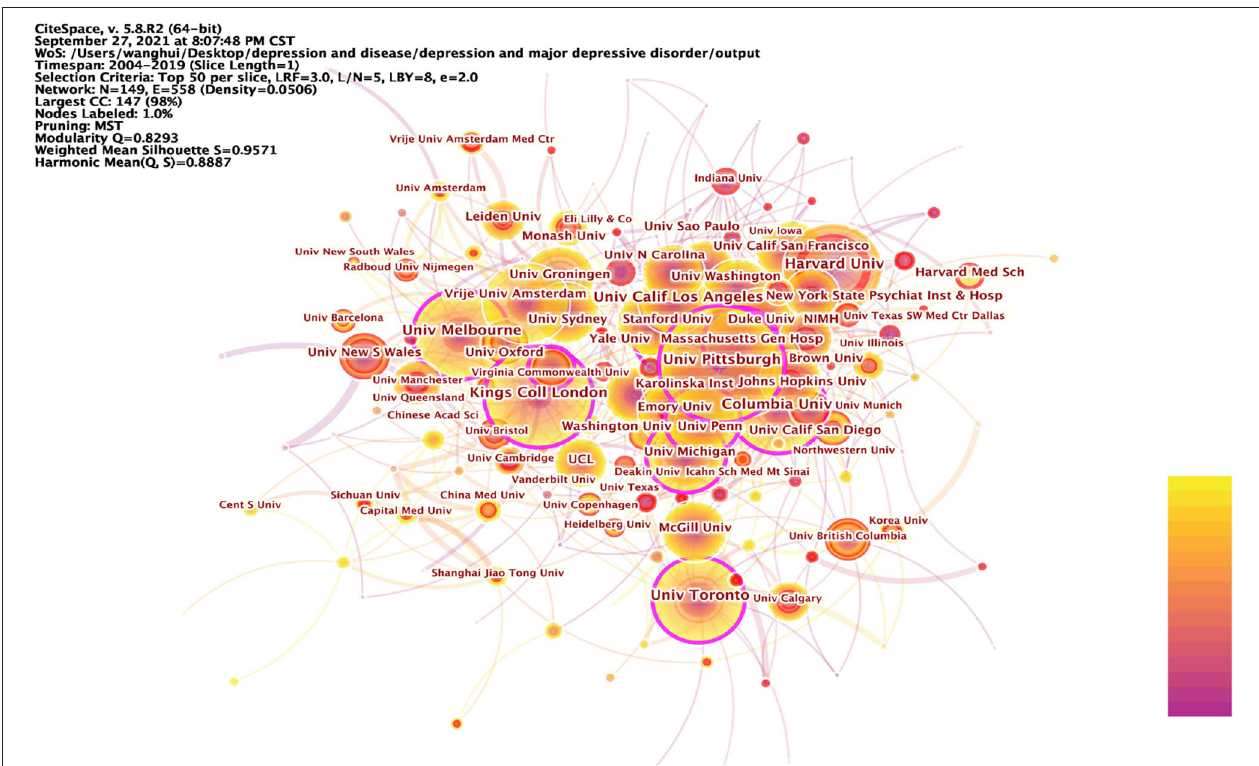
FIGURE 6 | Prominent institutions involved in depression, 2004–2019. The betweenness centrality of a node in the network measures the importance of the position of the node in the network. Two types of nodes may have high betweenness centrality scores: (1) Nodes that are highly connected to other nodes, (2) Nodes are positioned between different groups of nodes. The lines represent the link between two different nodes.